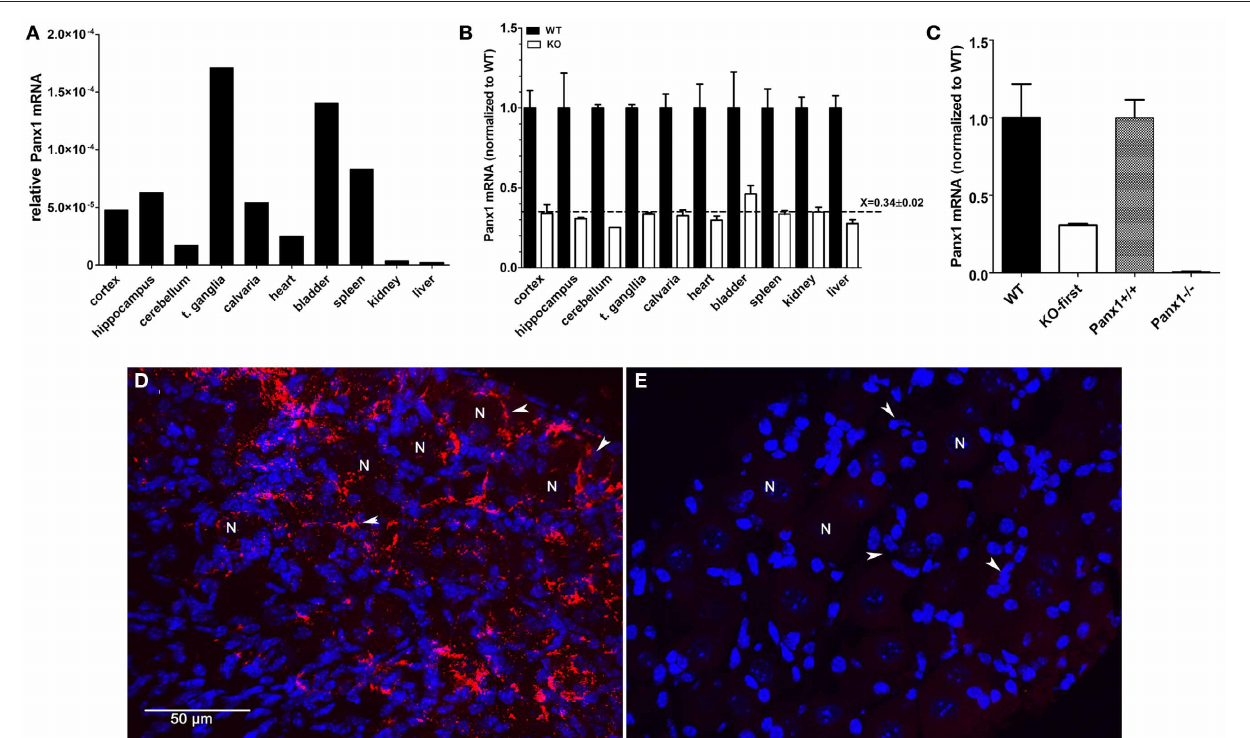
FIGURE 3 | Panx1 mRNA expression is decreased by 70% in tissues from Panx1 KO-first mice. (A) Panx1 mRNA expression levels (normalized to 18S RNA) obtained by qRT-PCR from various tissues of wild-type mice using primers spanning exons 4 and 5 of Panx1 (primer set F3—R3 depicted in Figure 1 ). (B) Bar histograms of the mean ± s.e.m. values of Panx1 mRNA obtained by qRT-PCR of various tissues of wild-type (black bars) and Panx1 KO-first (white bars) mice. Panx1 KO-first mRNA expression levels (normalized to that of 18S ) was calculated relative to those of wild-type. RNA was extracted from 10 different tissues of 3 mice per genotype. Dotted line represents the mean ± s.e.m. value of Panx1